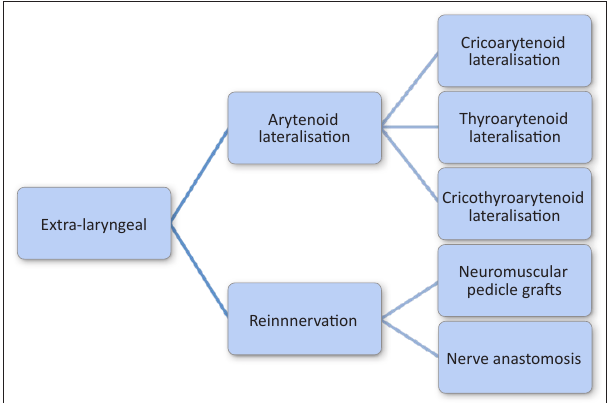
FIGURE 3: Schematic diagram indicating the different extra-laryngeal surgical procedures in dogs with laryngeal paralysis.